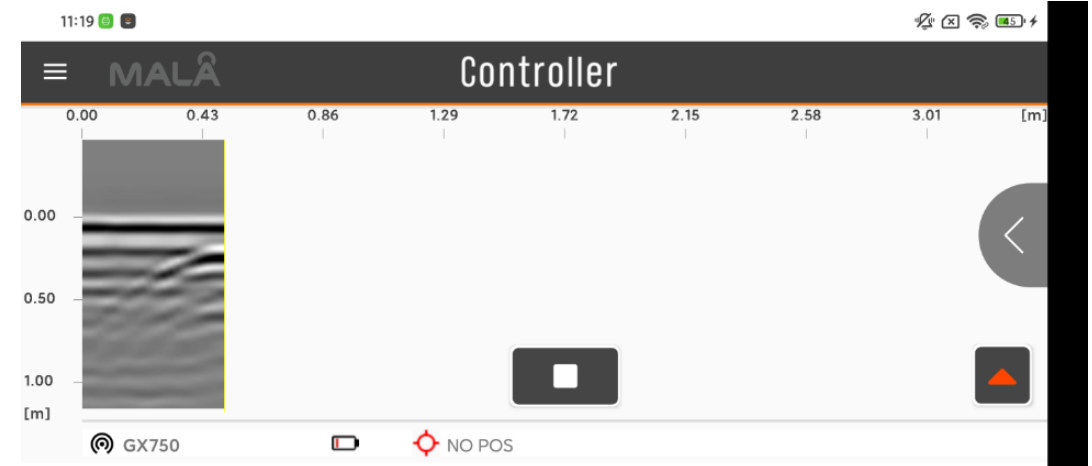
Figure 8. Test diagram of indoor real-time detection of steel bars.